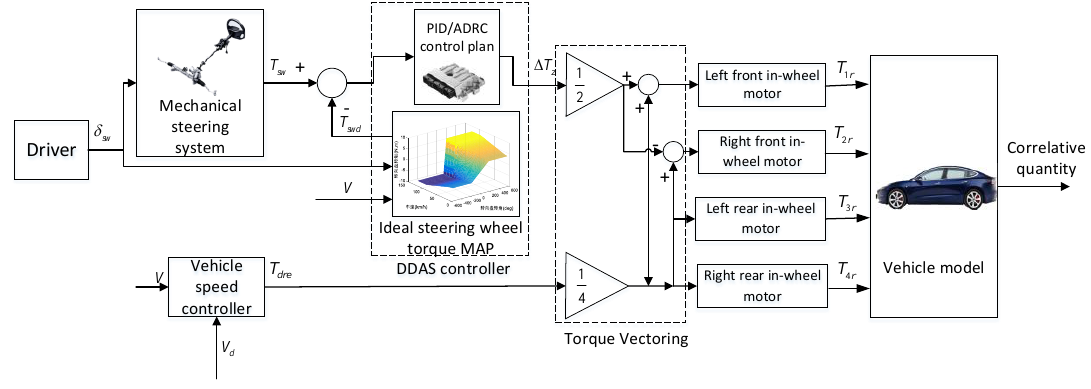
Figure 7. Steering-wheel-torque direct control strategy.